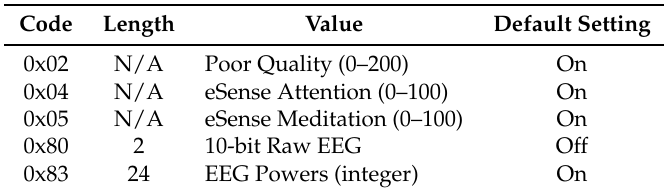
Table 2. ThinkGear